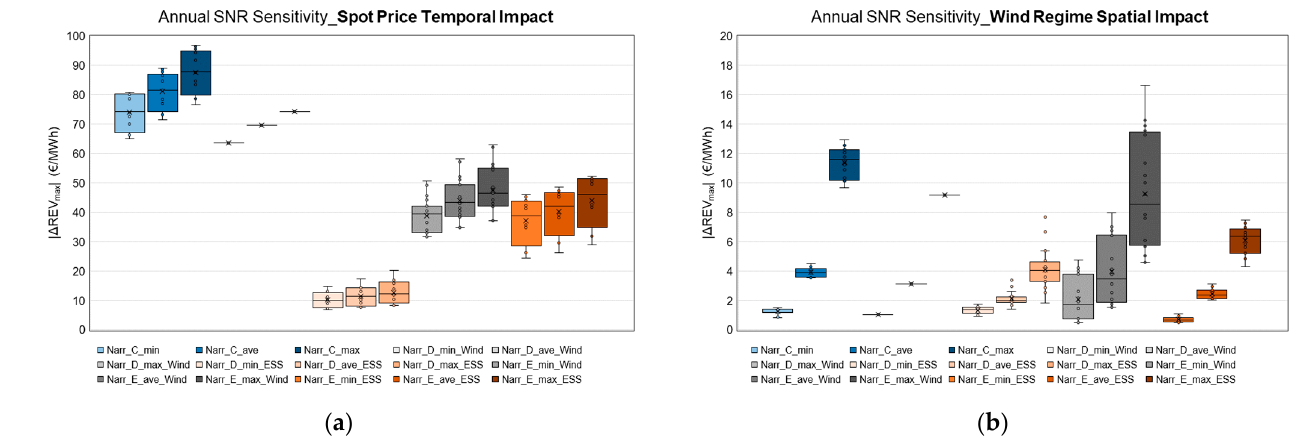
Figure 16. Maximum temporal ( a ) and spatial ( b ) sensitivity of the net speci fi c revenue per di ff erent wind storage narrative and for all con fi gurations examined.